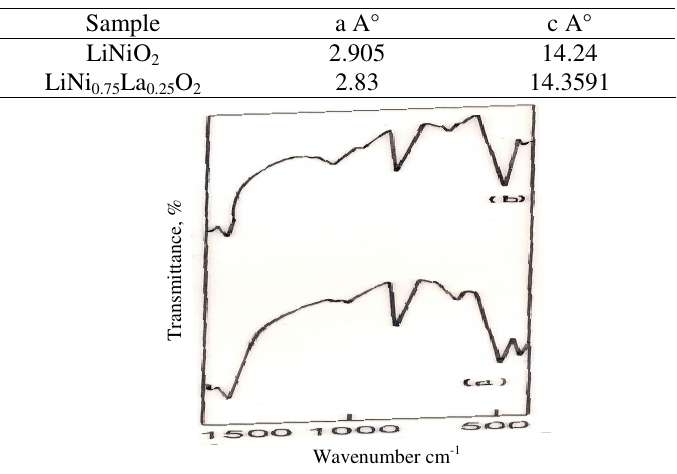
Figure 3. FTIR spectra of (a) LiNiO